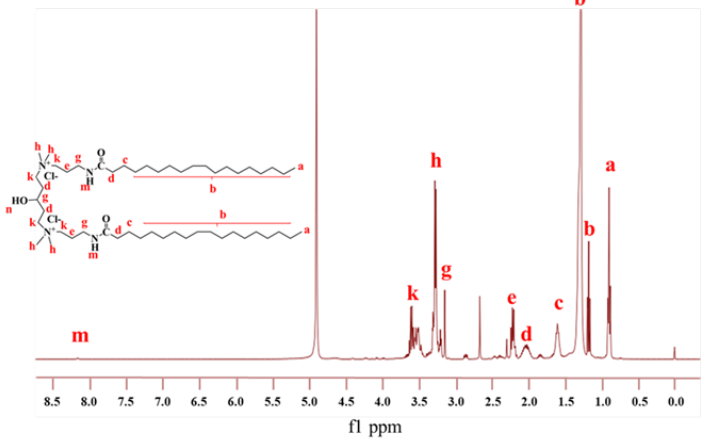
Figure 4. 1 H NMR spectrum of GOHAC.